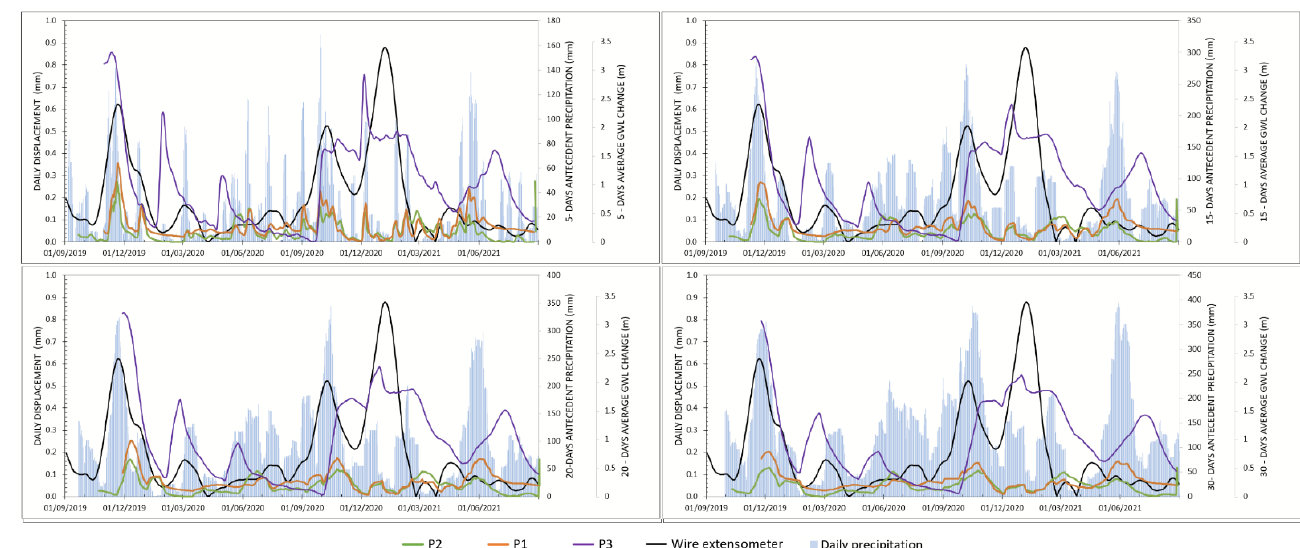
Figure 7. Time-series diagram showing the relationship among the daily displacements obtained by the extensometer; 5-, 15-, 20-, and 30-day antecedent precipitation; and 5-, 15-, 20-, and 30-days of average change in the groundwater table.